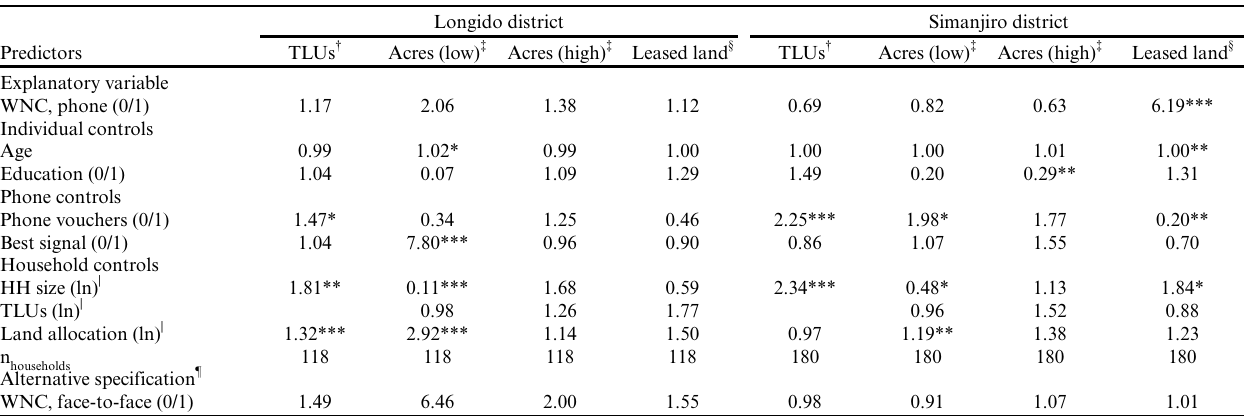
Table 2 . Variable incidence rate ratios, relative risk ratios, odds ratios and significance tests for Poisson, multiple logistic, and logistic regression models of livelihood measures in the prior 12 months. WNC = wrong number connections; TLUs = tropical livestock units. Longido